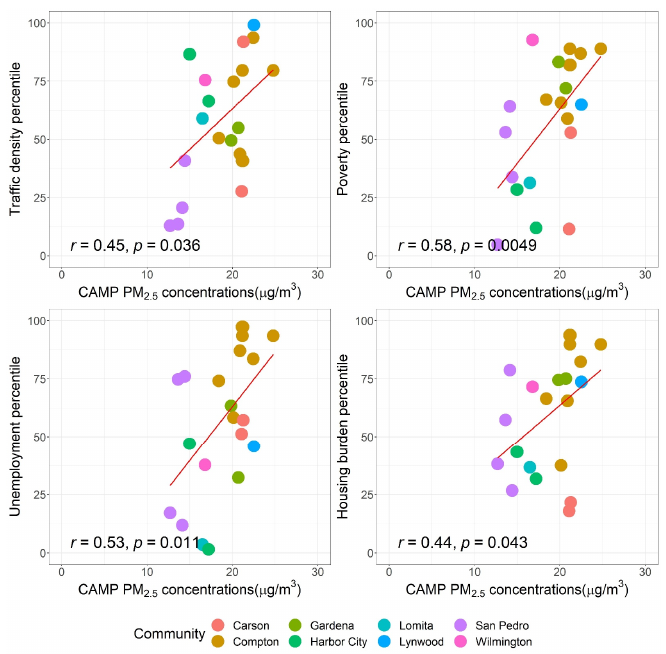
Figure 3. The correlations of residential outdoor PM 2.5 concentrations and percentiles of traffic density, poverty, unemployment, and housing burden. Int. J. Environ. Res. Public Health 2022 , 19 , x FOR PEER REVIEW